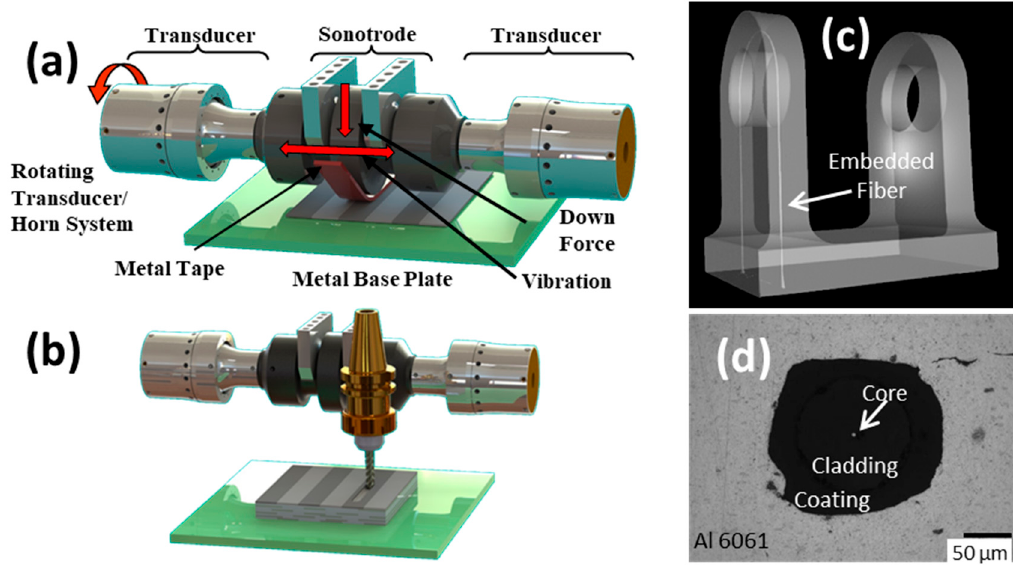
Figure 2. Embedding fiber optic strain sensors into metals using ultrasonic additive manufacturing (UAM): ( a ) Additive ultrasonic welding stage; ( b ) Subtractive computer numerical control (CNC) machining stage; ( c ) CT scan of aluminum bracket with embedded fiber around stress concentrator for damage monitoring, courtesy J. Sietins of Army Research Lab; ( d ) micrograph showing sensor consolidation into metal via UAM.